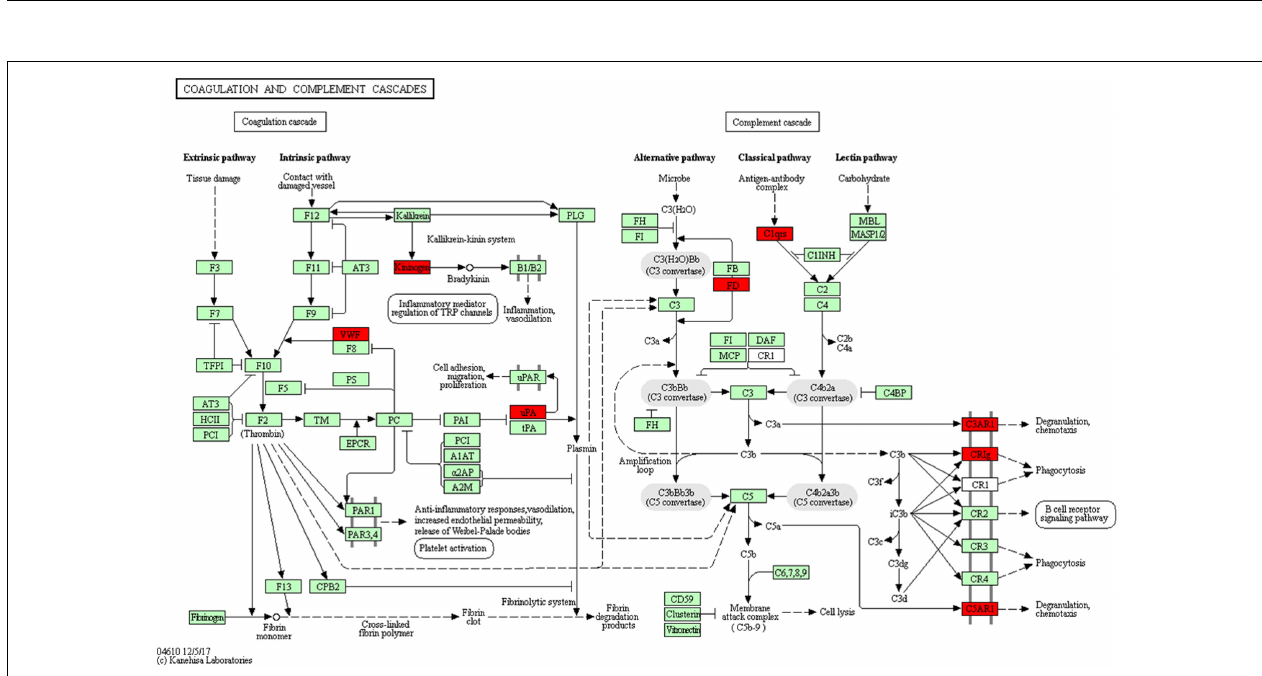
FIGURE 9 | Significantly enriched KEGG pathways in complement and coagulation cascades. The up-DEGs are marked in red. The pictures were drawn by KEGG Mapper (www.kegg.jp/kegg/tool/map_pathway2.html).